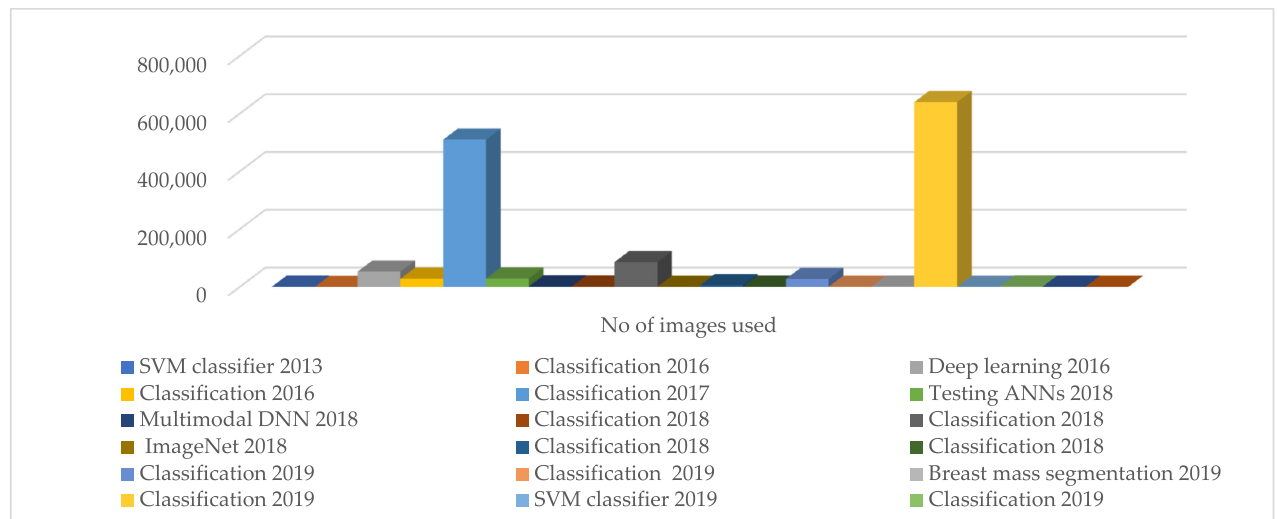
Figure 4. Summary of task, date, and number of images or studies used in figure.